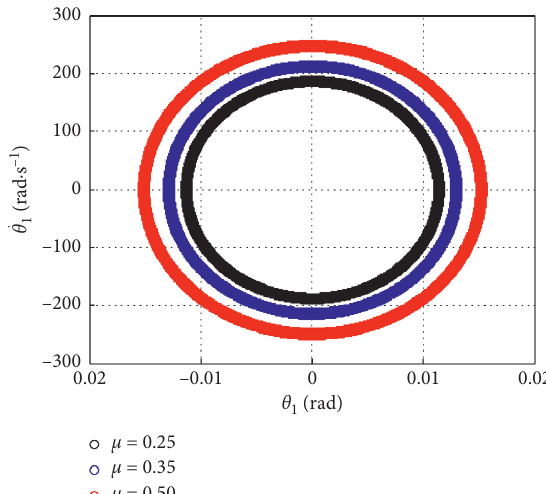
Figure 4: Dispersion of the limit cycles determined with (CHBM +ngPC) ( r � 8; Δ μ � 0.05; Δ V